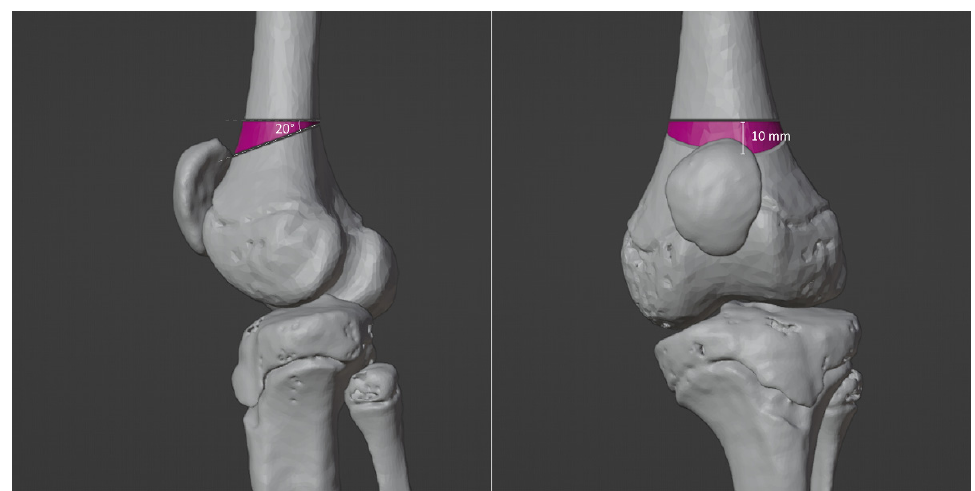
Figure 9. Closed wedge simulation. The left femur had to be corrected by 20° in extension.